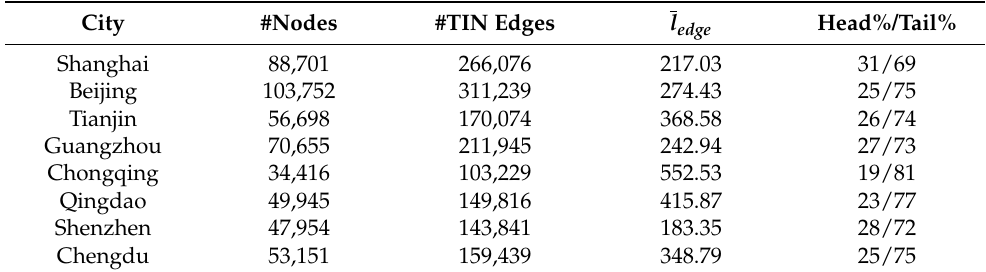
Table 1. Statistics of street nodes, related triangulated irregular network (TIN) edges, and head/tail division results among 20 cities. (Note: #: Number; l edge : Average edge